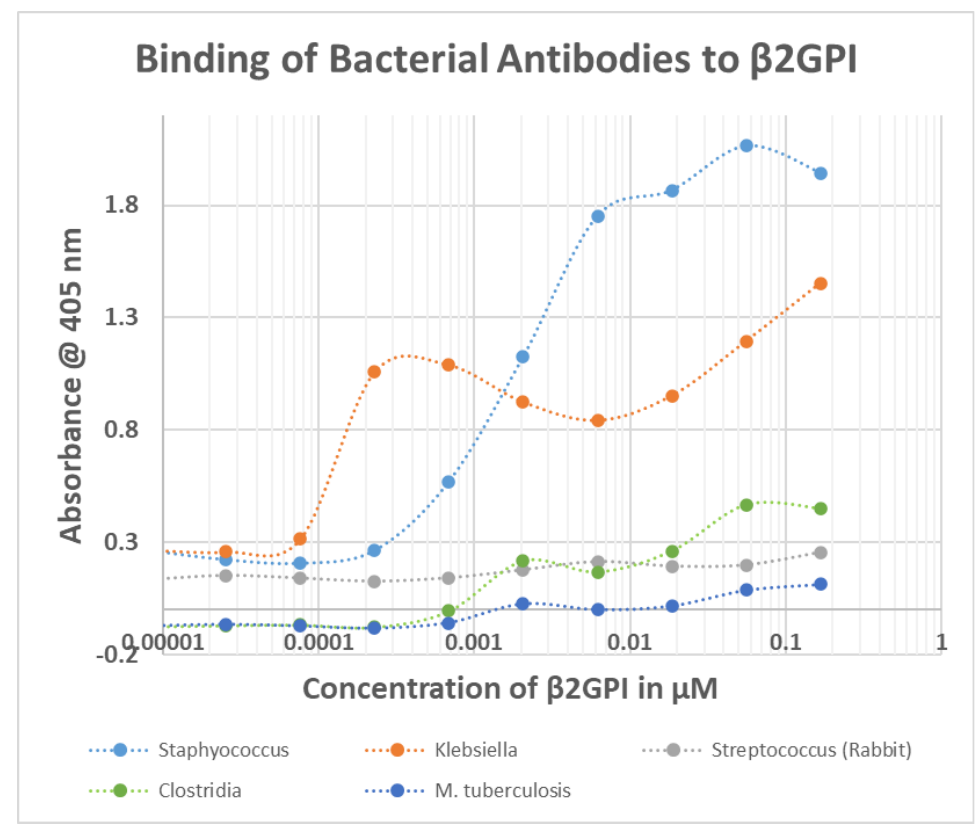
Figure 8 . Binding of bacterial antibodies to beta 2 glycoprotein I (β2GPI). These a re the results of a single experiment, which is why there are no error bars. Results were confirmed in by separate replication.